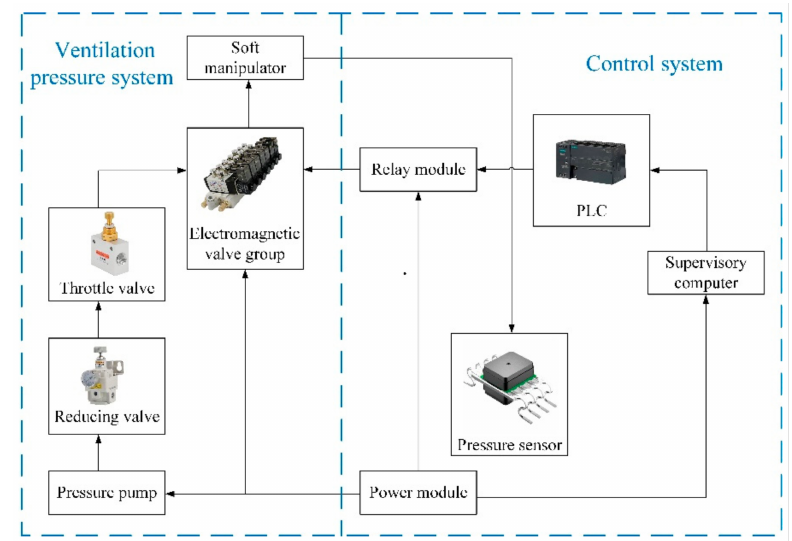
Figure 9. Experimental control